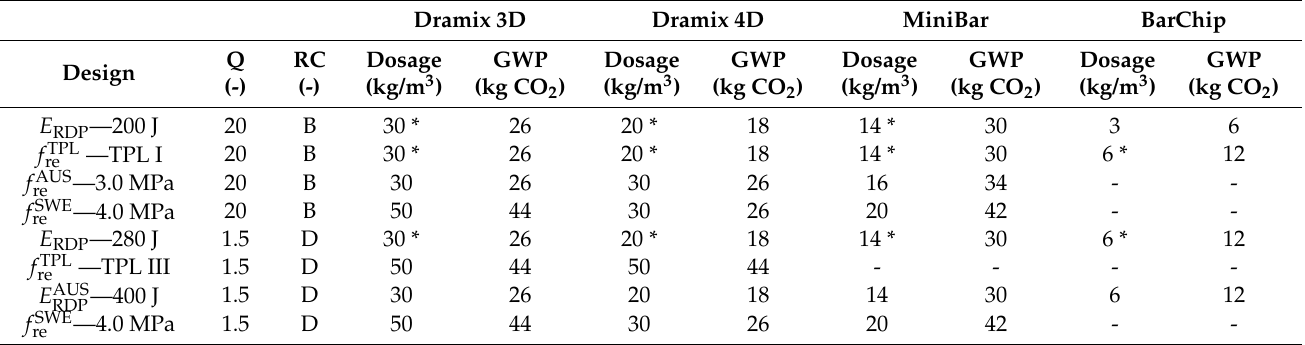
Table 8. Suitable dosage of fibres and GWP for required fibre dose for different design cases, Q-values and rock class (RC).